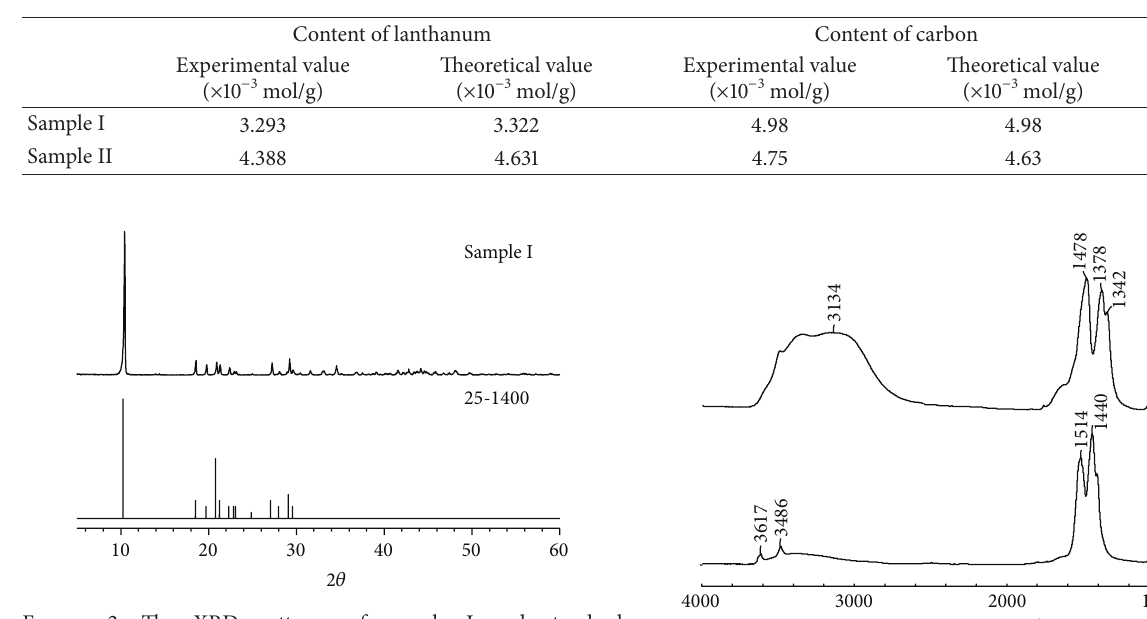
Table 1: Results on the chemical analysis of sample I and sample II.